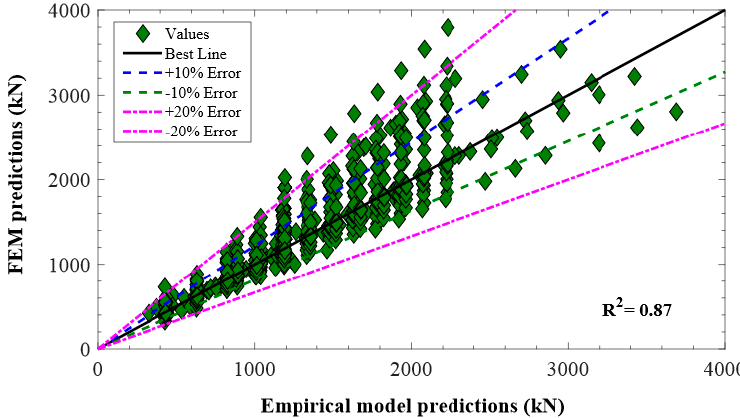
Figure 15. Comparison of predictions of anticipated empirical and FEM.